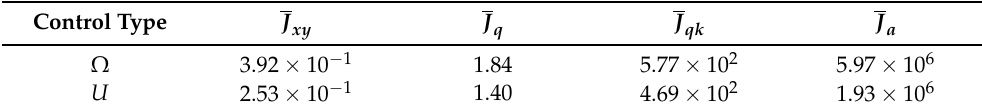
Table 4. Comparison of quality indicators depending on the type of control.